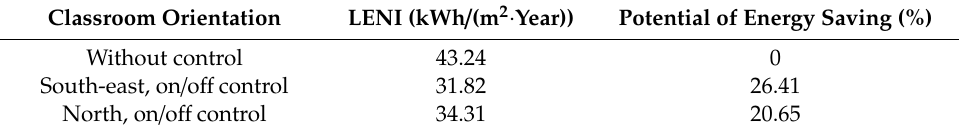
Table 4. LENI calculated according to EN 15193 1: 2017-08 and potential of energy